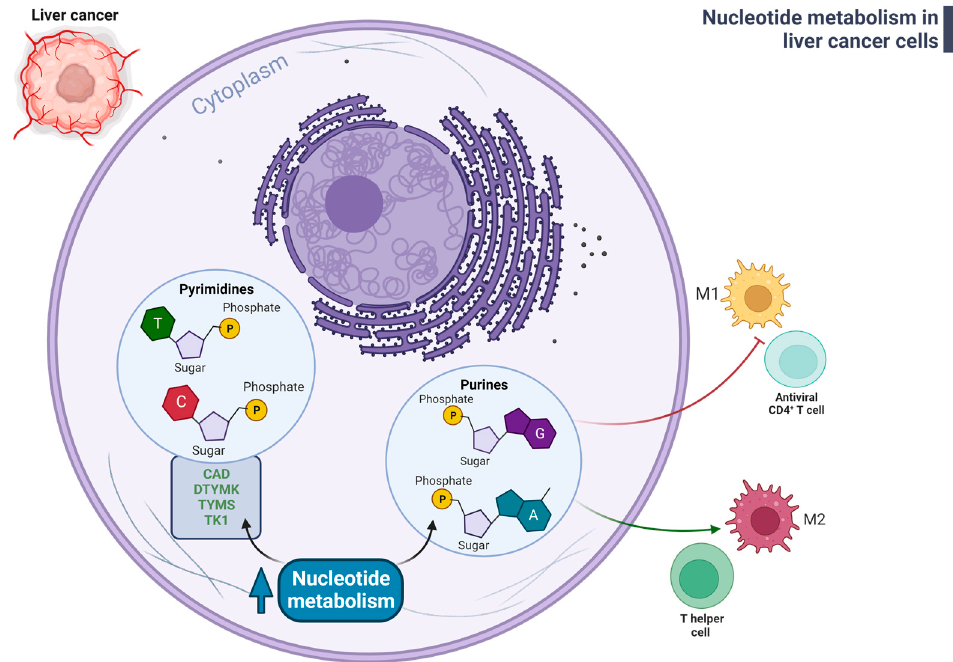
Figure 4. Deregulated nucleotide metabolism in liver cancer cells affects immune microenvironment. As illustrated in the review’s text, up-regulation of nucleotide metabolism is necessary to sustain liver cancer cells proliferation but can affect the recruitment and/or the functionality of immune cells, potentially favor cancer progression and/or immune escape of liver cancer cells. Abbreviation: CAD, carbamoyl phosphate synthetase 2, aspartate transcarbamylase and dihydroorotase (CAD); DTYMK, deoxythymidylate kinase, TYMS, thymidylate synthase, TK1, thymidine kinase 1. M1 and M2: M1 macrophages phenotype and M2 macrophages phenotype. Legend: green arrows and green bold text indicate up-regulated pathways; red arrows and red bold text indicate down-regulated pathways. Created with BioRender.com.